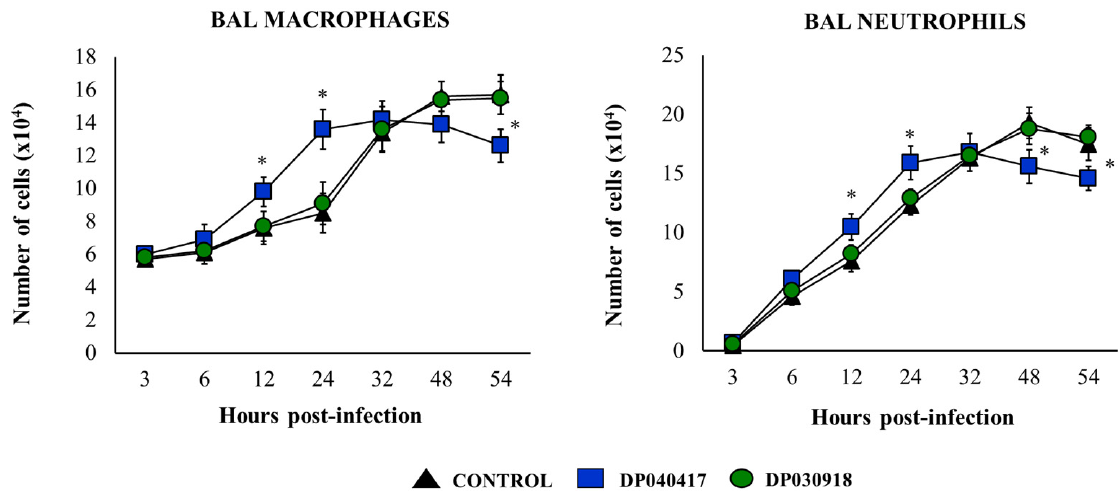
Figure 3. Effect of the respiratory commensal bacteria Dolosigranulum pigrum on resistance to Streptococcus pneumoniae infection. Infant mice were nasally primed with viable D. pigrum (DP) strain 040417 or 030918 during five consecutive days at a dose of 10 8 bacterial cells/mouse/day. One day after the last administration of DP strains, mice were challenged with S. pneumoniae serotype 3. Non-treated infant mice challenged with S. pneumoniae were used as controls. Macrophages and neutrophils numbers in broncho-alveolar lavages (BAL) were evaluated on different time points after the bacterial challenge. The results represent data from three independent experiments ( n = 6 per each group at each time point). Significantly different when compared with control at the same time point, * p < 0.05.